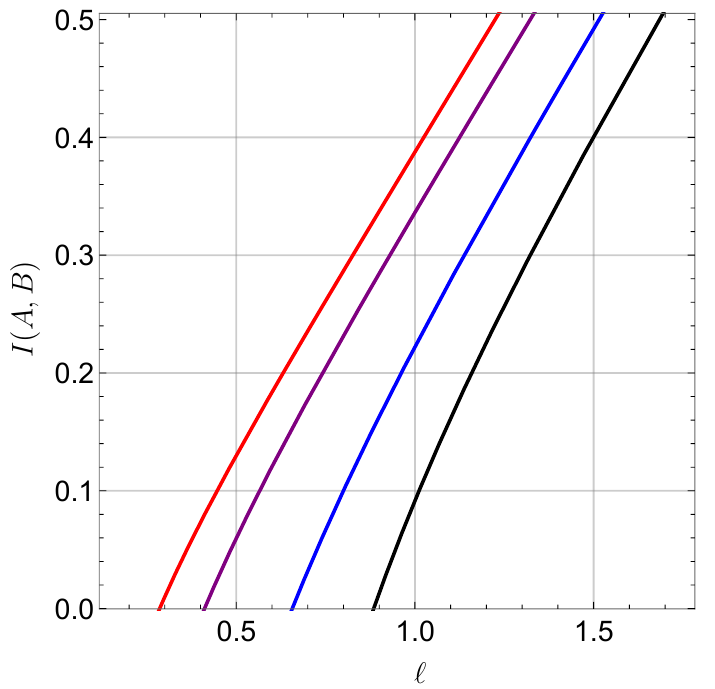
Figure 3 . Mutual Information (in units of L 2 R 3 =G (5) non-commutative SYM theory. The curves correspond from the right to the left to a = 0 (black curve), a = 0 : 8 (blue curve), a = 1 : 2 (purple curve) and a = 1 : 2 (red curve) . In all cases we have (cid:12)xed r = H